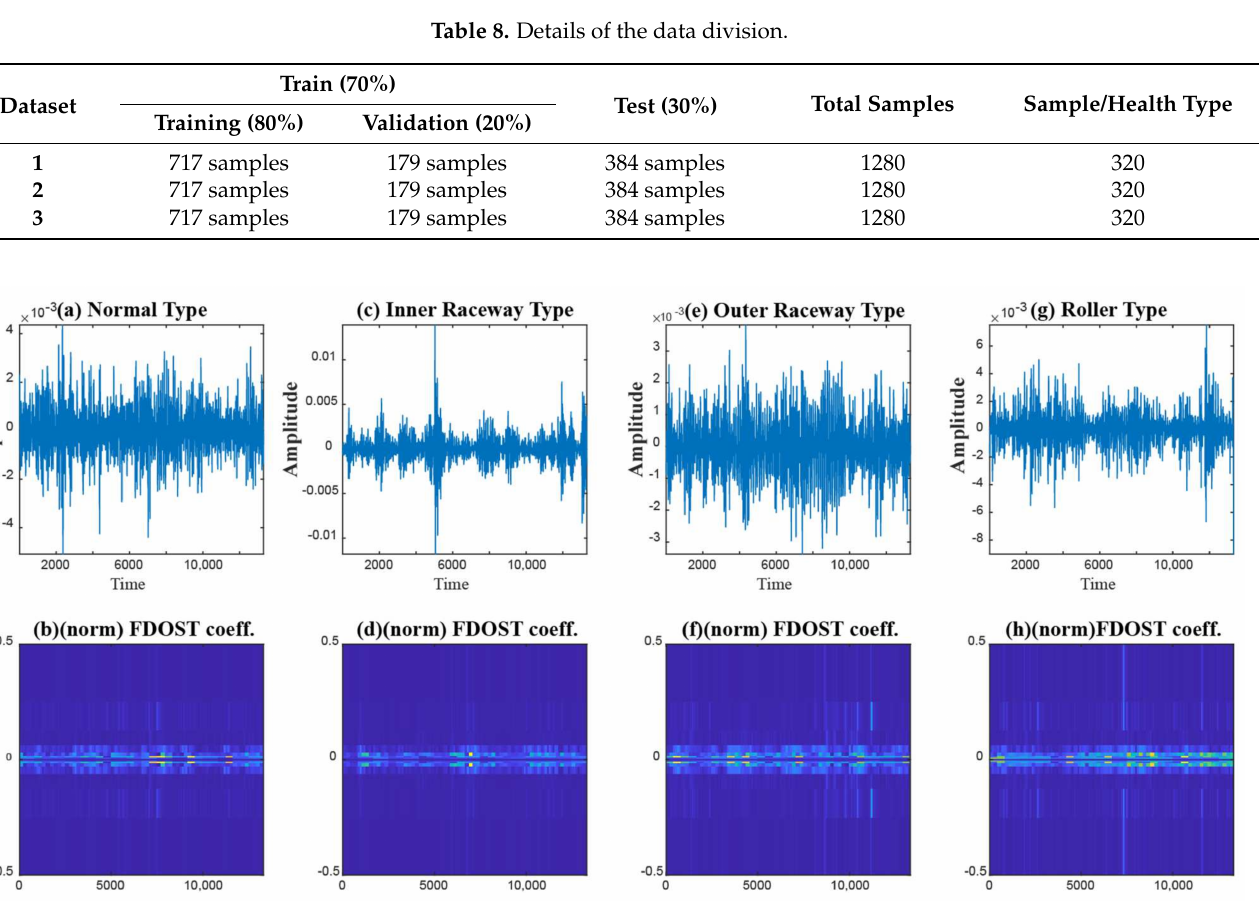
Figure 16. The visualization of dataset 1 in terms of raw time domain signals and the respective 2D FDOST coefficient matrix—( a , b ): time domain, and 2D FDOST coefficient of NT, ( c , d ): time domain, and 2D FDOST coefficient of IRT, ( e , f ): time domain, and 2D FDOST coefficient of ORT, and ( g , h ): time domain, and 2D FDOST coefficient of